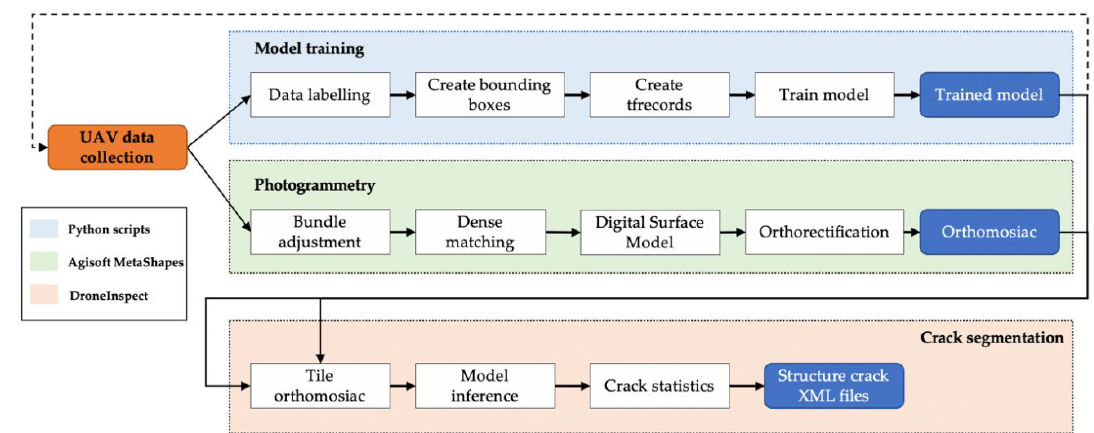
Figure 1. Proposed methodology for inspection assessment via the use of Unmanned Aerial Vehicles (UAV) image